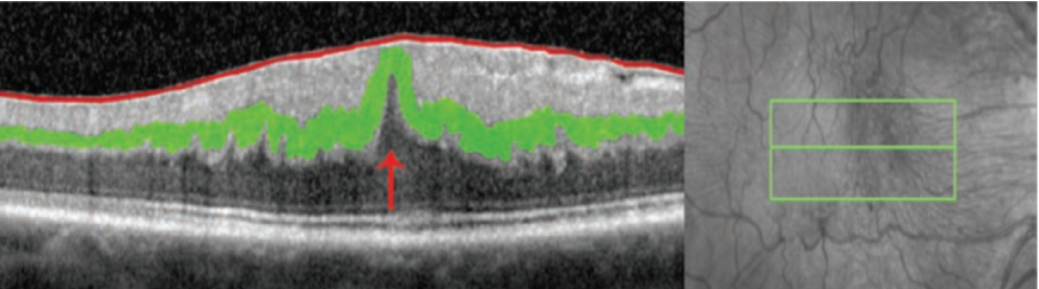
Figure 9. Retinal distortion due to the formation of ERM.